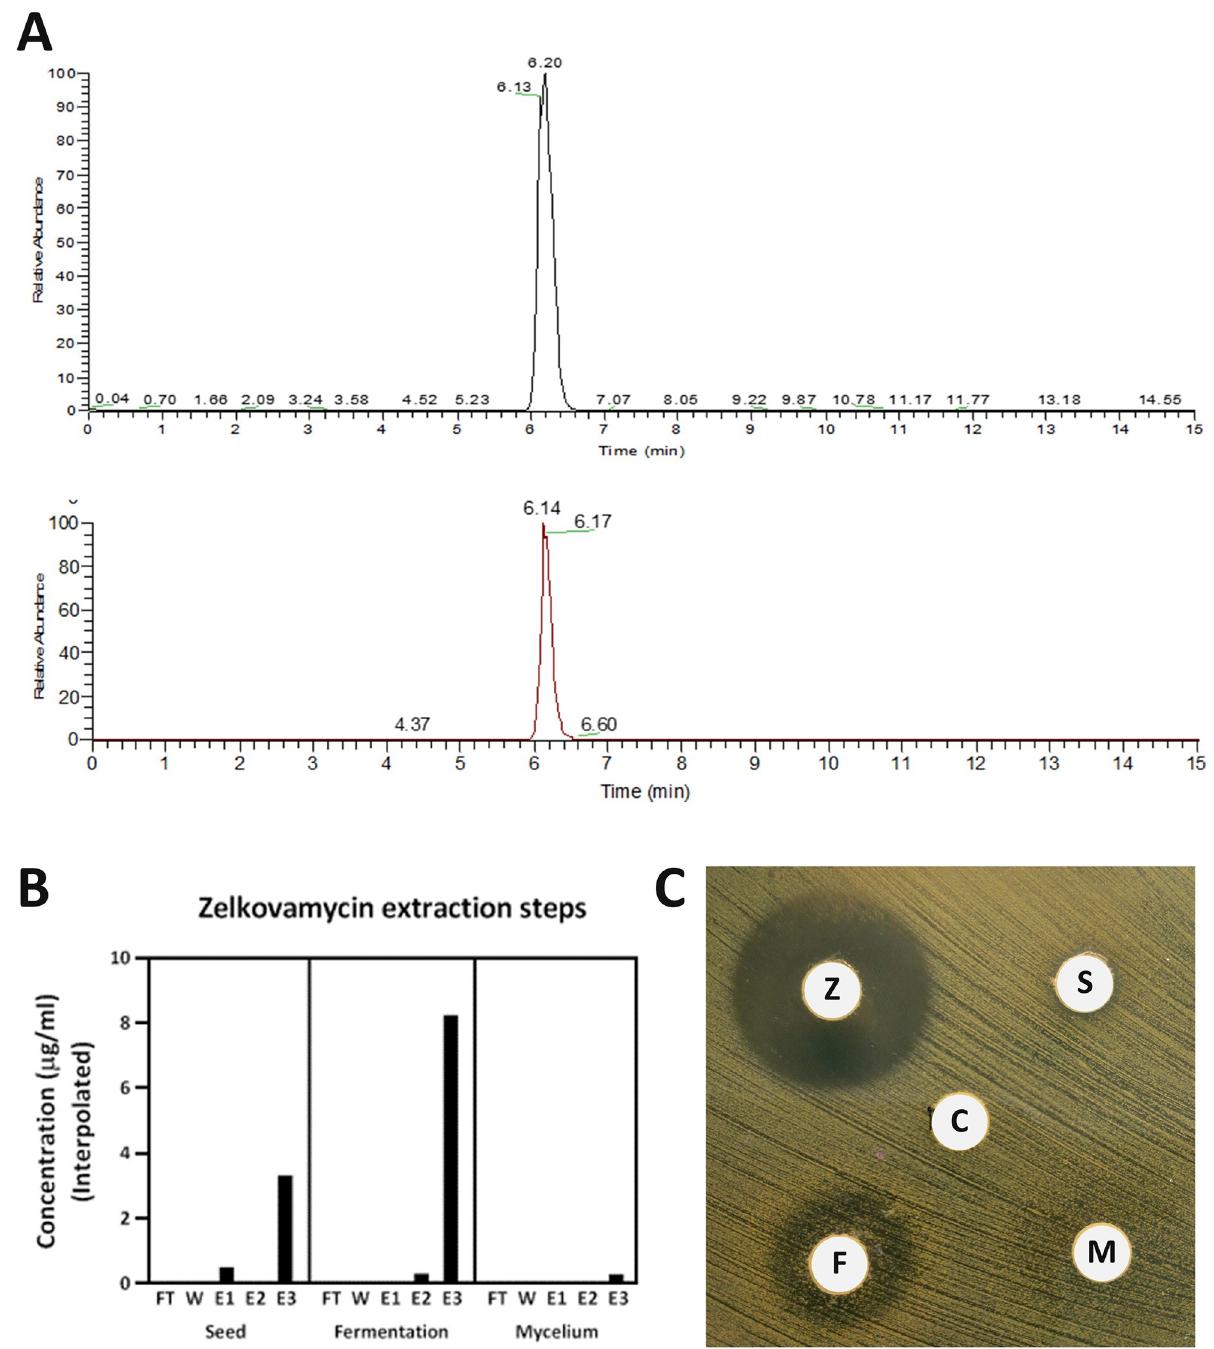
Fig 5. Detection, purification and antibiotic activity of zelkovamycin from Actinomadura sp. 32–07. (A) Extracted ion chromatograms of commercial zelkovamycin (top) and a representative example of an extracted sample (bottom). Zelkovamycin can be detected as a monodisperse peak eluted at 6.14 min. (B) Zelkovamycin extraction steps from the inoculum medium, the fermented medium and the harvested mycelium. The compound is present in both culture media and can be successfully extracted upon resin elution with 100% methanol. (C) Antibiotic sensitivity testing on S . aureus SH1000 using the most concentrated zelkovamycin extracts (E3) from each fraction. The lower concentration of antibiotic in the extracts obtained from the seed culture and the mycelium is reflected by their significantly lower, albeit detectable, inhibitory activity. FT: flow-through; W: water wash; E1–3: 20%, 50% and 100% MeOH elution, respectively; Z: zelkovamycin standard (1 mg/mL); S: seed culture extract; F: fermented broth extract; M: mycelium extract; C: 100% MeOH control.